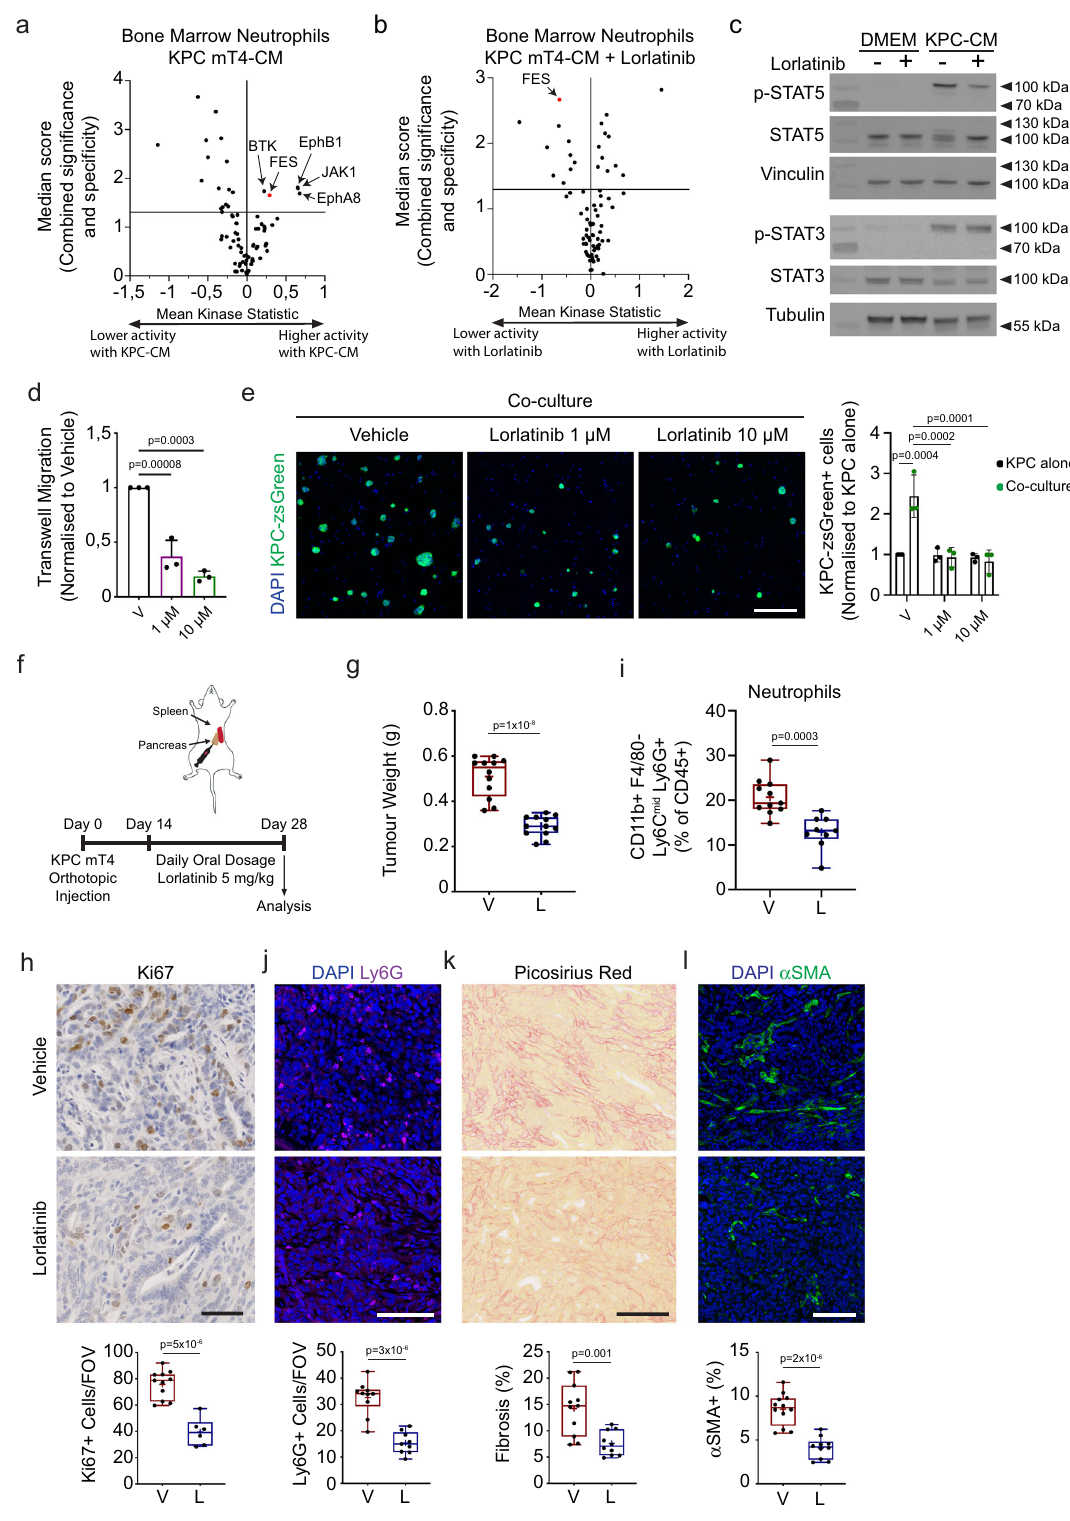
Lorlatinib attenuates PDAC growth by suppressing neutrophil accumulation . Lorlatinib shows promising results in clinical trials with patients suffering from non-small-cell lung cancer with genetic rearrangement of ALK or ROS1 24,25 , however, only a very small percentage of human PDAC patients have detectable ALK expression 37 . Based on our results on neutrophils in vitro, we decided to test whether lorlatinib could inhibit PDAC tumor